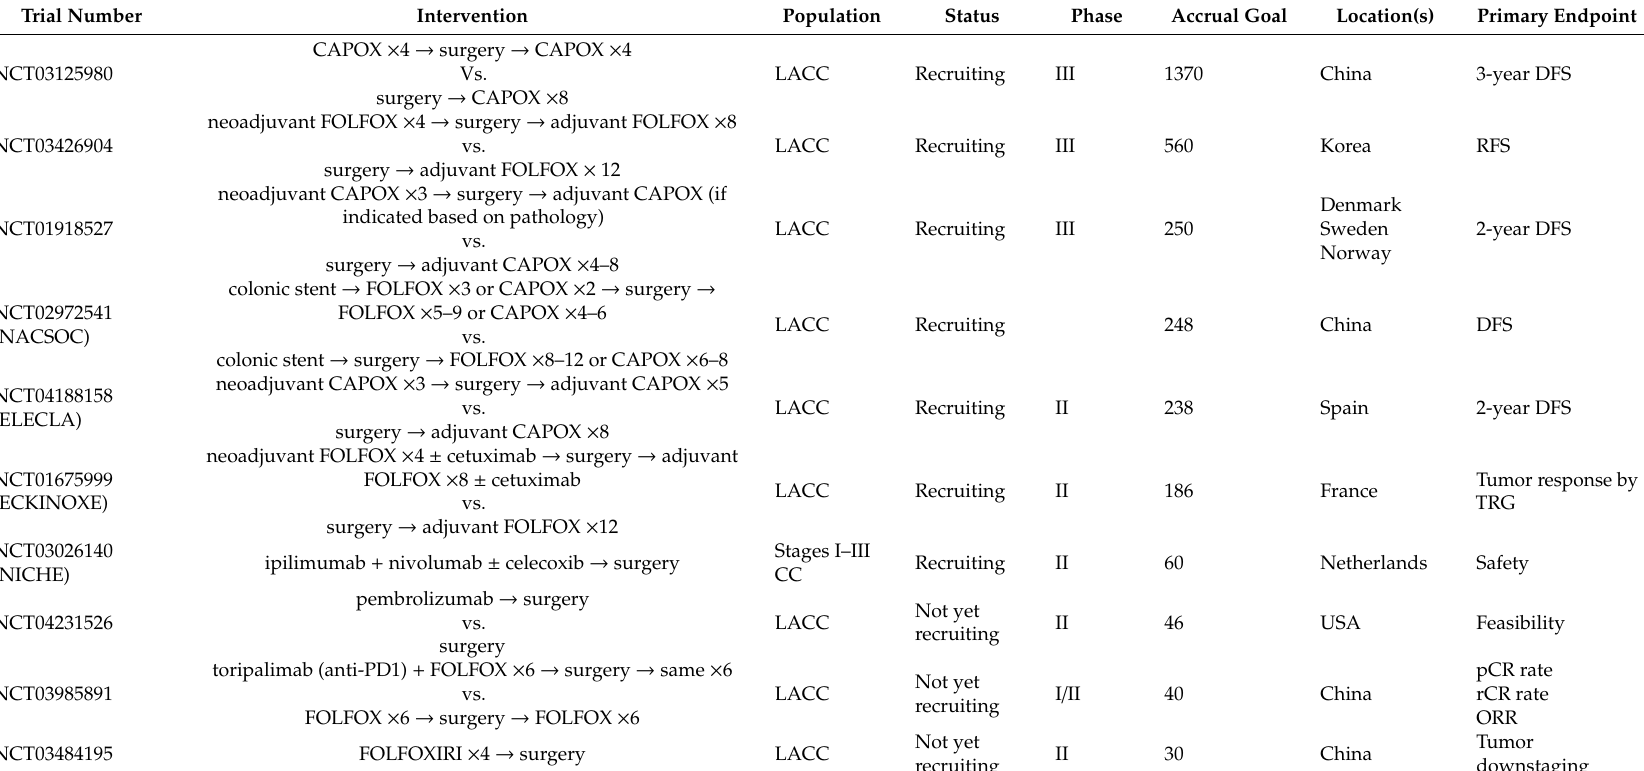
Table 1. Ongoing neoadjuvant therapy trials in localized colon